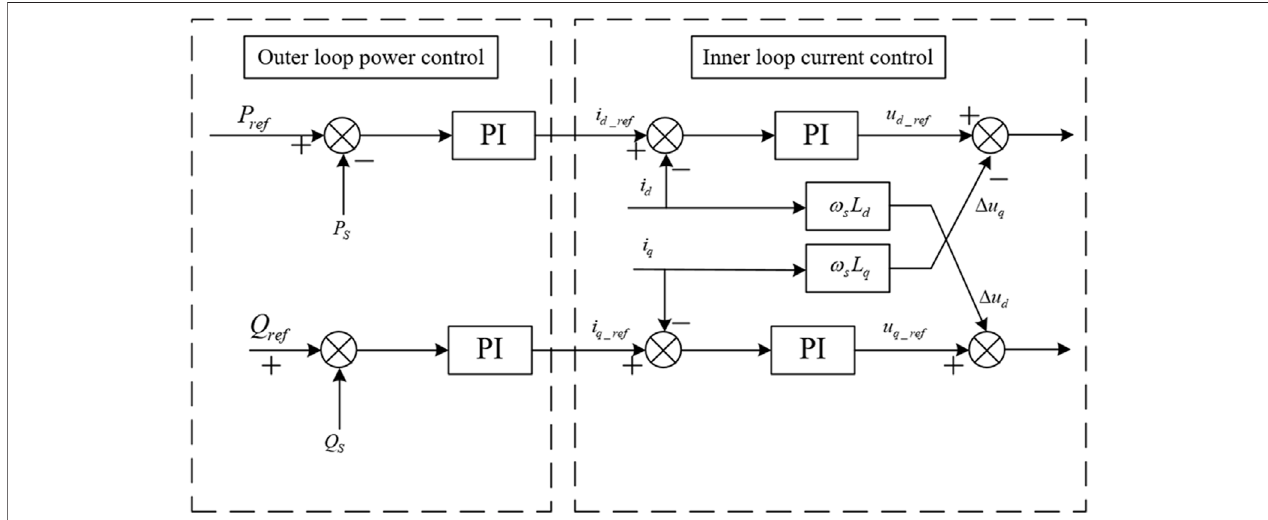
FIGURE 4 | Control block diagram of the rotor side converter and machine side